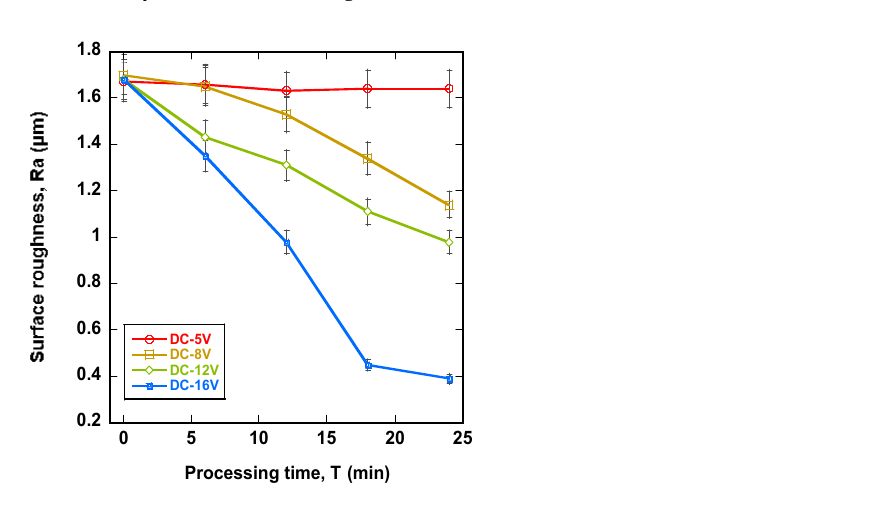
Figure 4. Instrument testing surface roughness of brass cone pipe (Mitutoyo SJ-400).